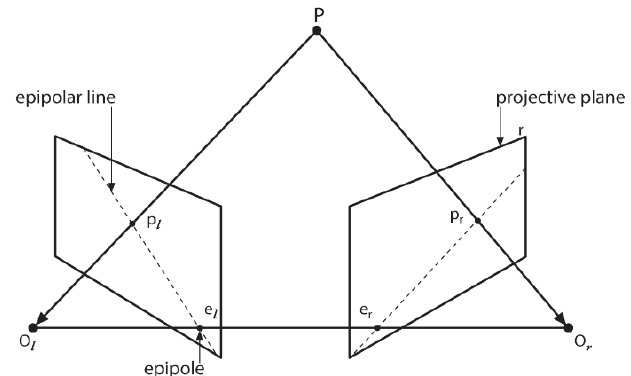
Figure 7. Epipolar geometry constraint.